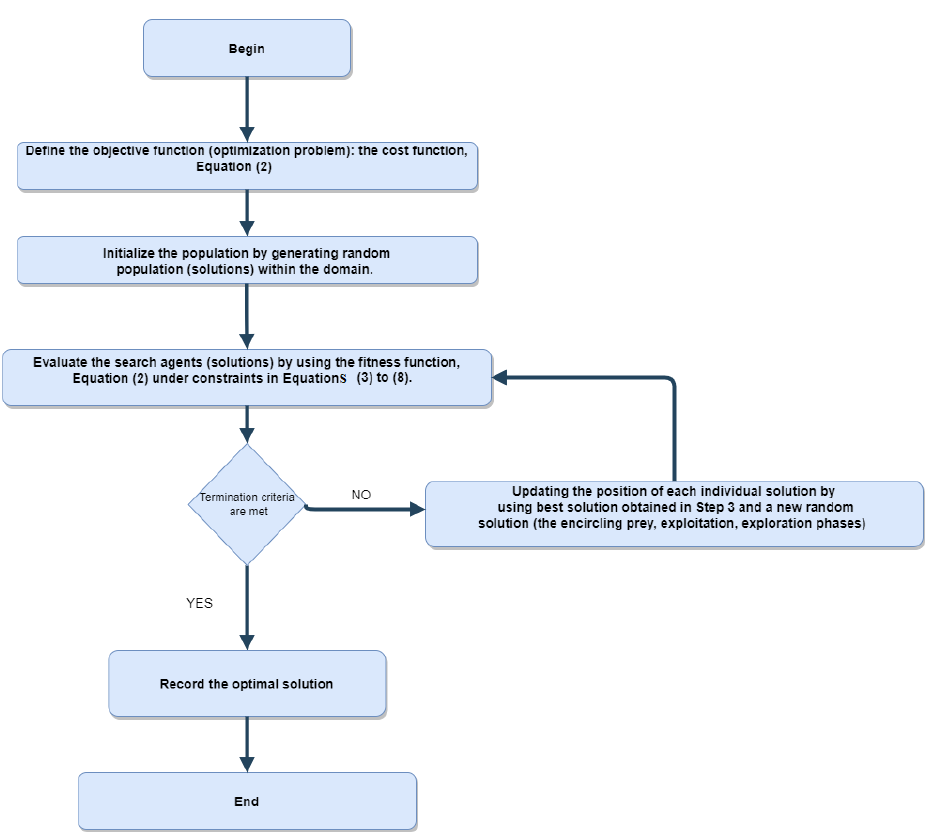
Figure 3. A flow chart of Whale Optimization Algorithm (WOA) for the HAPF problem.